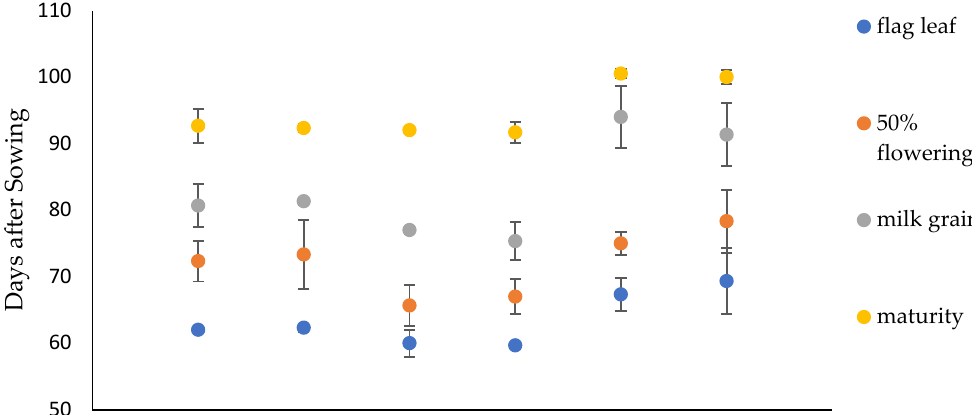
Figure 4. Phenological Development of Different Cultivars in N’Gakoro in 2019. Sowing date: 13 July 2019. Waterlogging from DaS 52 to 72. Irrigations (I) at DaS 79 and 89. NI = no irrigation (rainfed), I = additional 2 × 20 mm during grain filling. N (no. of repetitions) = 3